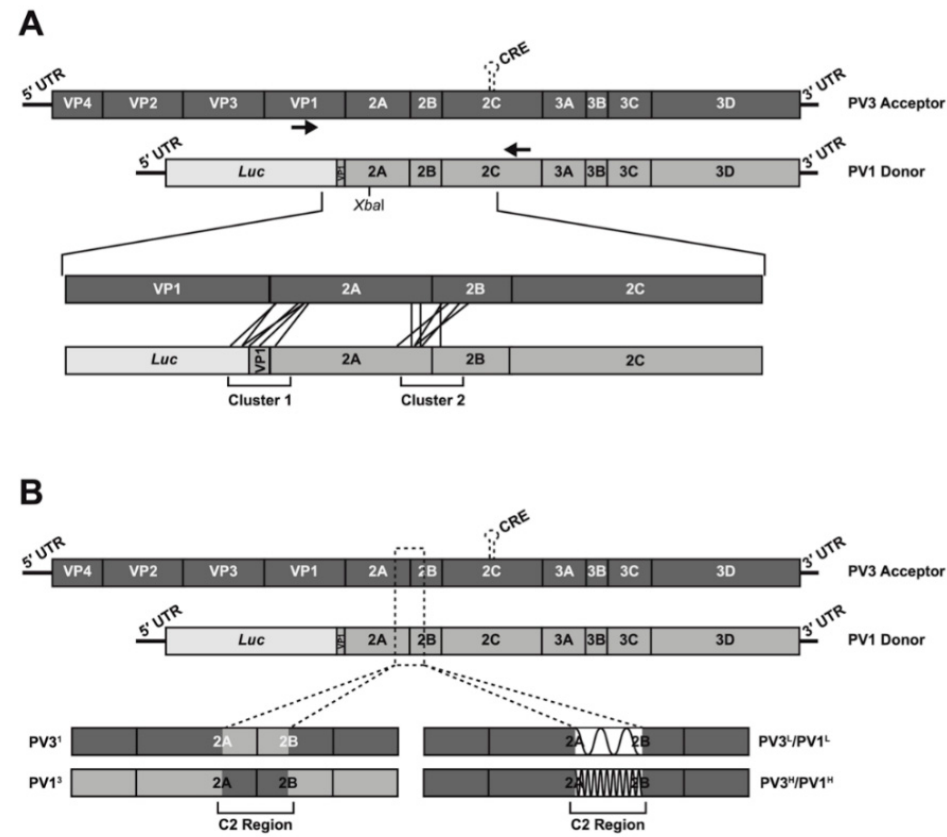
Figure 1. Schematic representation of CRE-REP assays. ( A ) Intertypic CRE-REP assay showing the genomes of the PV3 acceptor and PV1 donor RNAs. Black arrows represent position of primers used to amplify recombinant genomes. The lower expanded image illustrates the recombination window and highlights examples of recombination events in Cluster 1 and Cluster 2. The position of a unique XbaI site used for screening is shown in the donor template. ( B ) Modified CRE-REP assays highlighting the region of modification within Cluster 2 and the resulting acceptor and donor templates with altered sequence identity or RNA secondary structure.